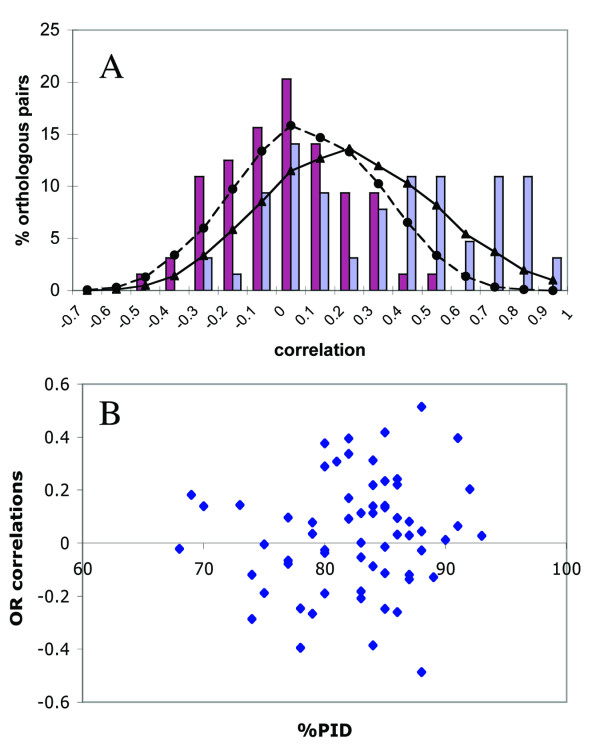
Pearson's correlations between expression profiles of human and mouse orthologs. Human and mouse expression profiles were extracted from the GeneAtlas2 project and the same methodology was used to normalize both of them. A. Frequency distributions of Pearson's correlations for a set of 9616 mouse-human orthologs (solid line with triangles) and a set of 9616 mouse-human randomly chosen gene pairs (dashed line with circles) as well as for 64 mouse-human orthologous OR pairs (dark gray/pink bars) and 64 mouse-human spermatogenesis related orthologous genes (light gray/blue bars). A significant difference between the correlations values in the orthologous OR and spermatogenesis genes groups was supported by Wilcoxon test (p < 0.0001). B. Pearson's correlations between mouse-human orthologous OR pairs were plotted against the protein identity percent within each pair.